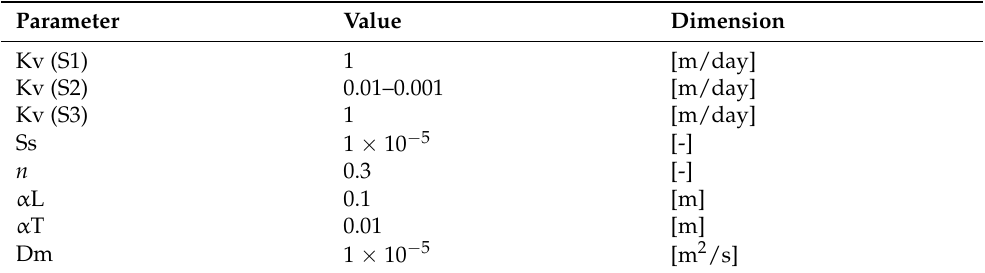
Table 2. Model parameters for numerical simulations: horizontal hydraulic conductivity (Kh), anisotropy ratio (Kv/Kh = 1/10), specific storage (Ss), porosity ( n ), effective molecular diffusivity (Dm), longitudinal dispersivity ( α L), and transverse dispersivity ( α T), effective molecular diffusion (Dm), for the upper sandy sediments aquifer (S1), mid argillaceous sediments aquitard (S2), lower sandy sediments aquifer (S3), based on [21]. Parameter